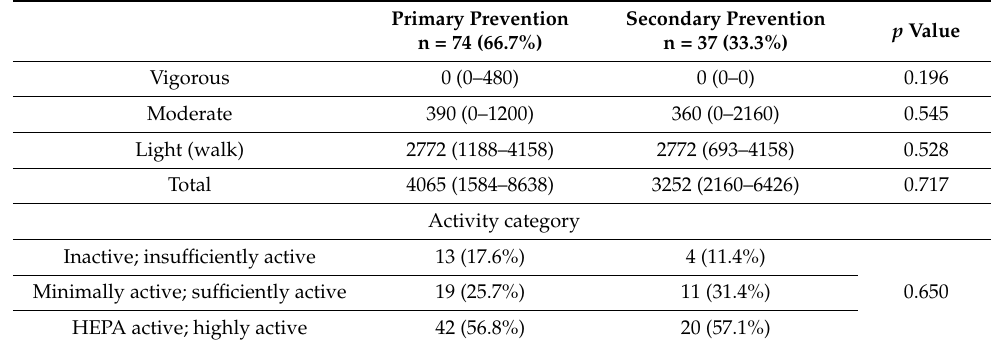
Table 4. Participants’ physical activity after implantation, according to type of prevention.